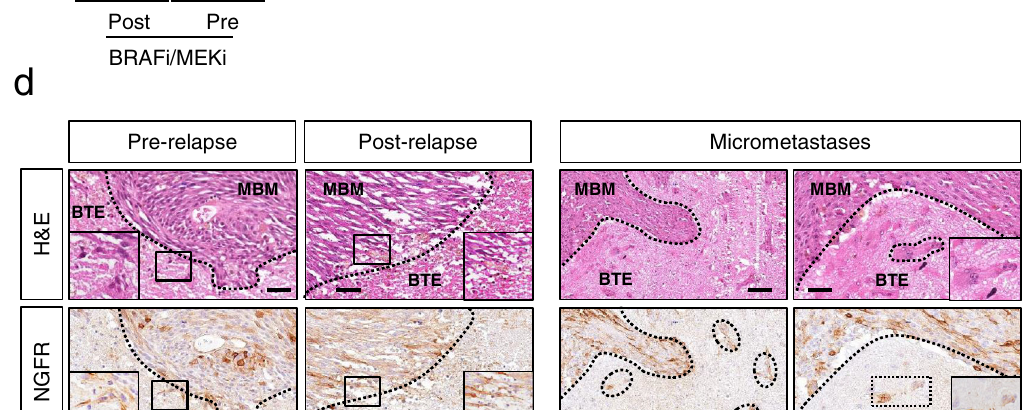
BRAF wt / NRAS mut and higher levels of Ecad in BRAF mut ( p =0.013) MBM (Supplementary Fig. 3e, center and right panels). Gene signatures clearly separated the fast majority of MBM with IHC-proven Ecad + or NGFR + phenotypes into distinct molecular subsets (Fig. 3a, b) and revealed no clear correlation with the degree of immune cell in fi ltra- tion as judged by the presence of CD3 + T cells (Fig. 3b, lower panels). Moreover, gene signatures uncovered intermediate state tumors